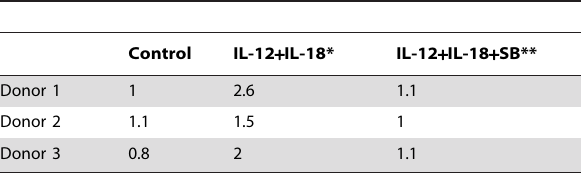
Table 3. Percentage of IFN- c + cells from CD4 + RO + IL-18R a + T cells as determined by intracellular